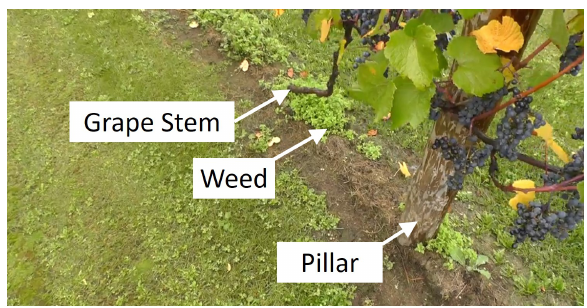
Figure 4. Grape stem, weed, and pillar in a vineyard. The Lidar sensor is setup at a height greater than that of the weeds. Hence, noise from weeds does not affect the accuracy of pillar detection.